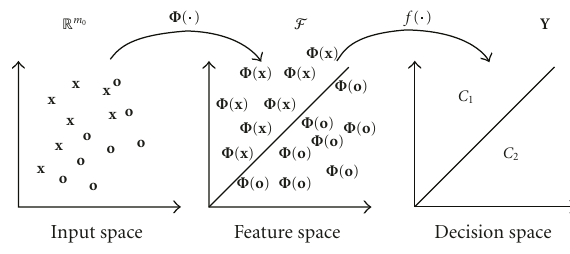
Figure 15: Di ff erent spaces and mappings in a support vector ma-